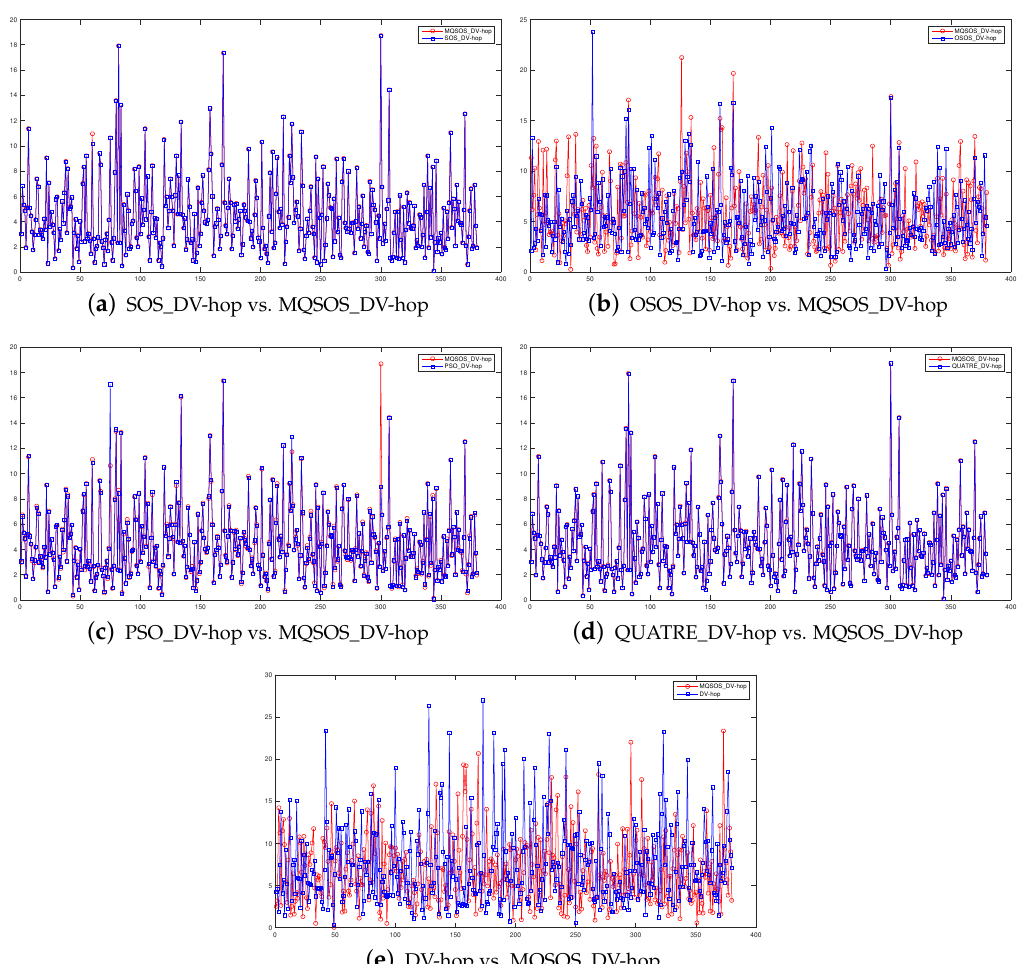
Figure 6. Comparison diagram of positioning errors between the MQSOS_DV-hop positioning algorithm and other positioning